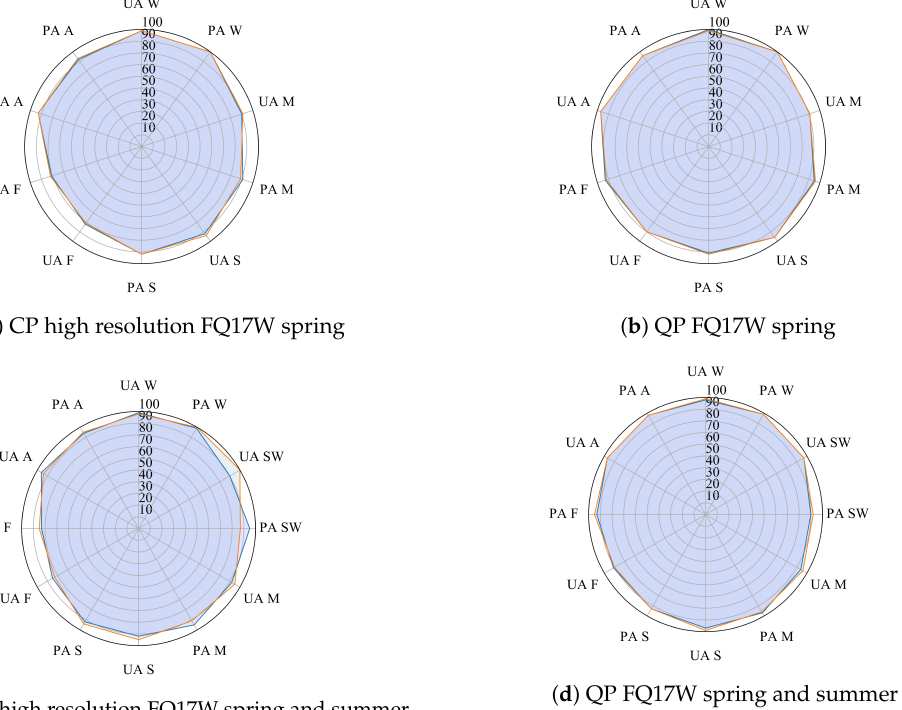
Figure 9. User’s (UA) and producer’s (PA) accuracies for water (W), shallow water (SW), marsh (M), swamp (S), forest (F), and agriculture/non-forested (A) for models based on QP or high resolution CP data processed and classified using either high spatial resolution DEM and DSM data (blue) or low spatial resolution DEM data